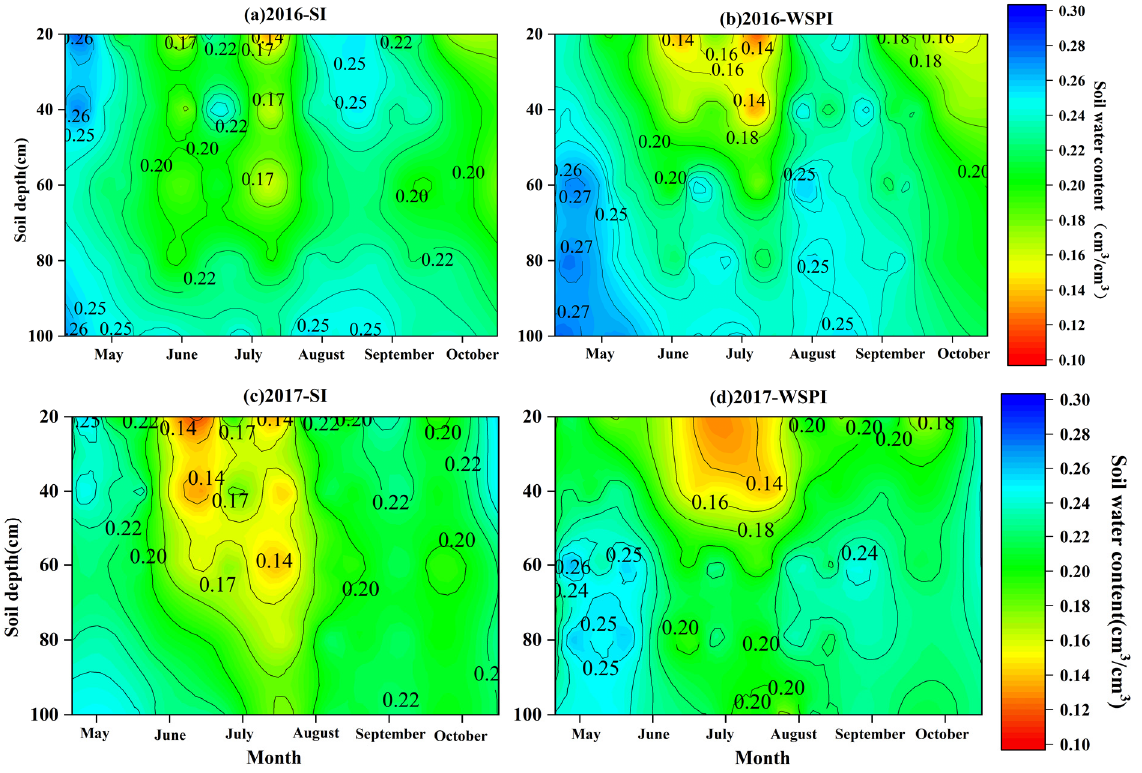
Figure 3. Seasonal variations of soil water content under surface irrigation ( a , c ) and water storage pit irrigation ( b , d ) in 2016 and 2017. WSPI means water storage pit irrigation, and SI means surface irrigation. Color changes indicate the magnitude of soil moisture content.